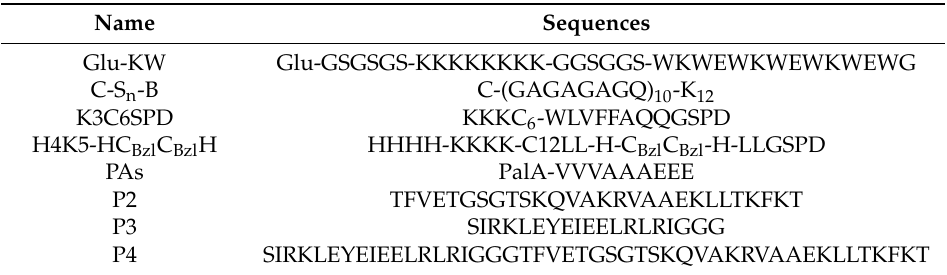
Table 4. Peptide sequence of supramolecular particles for nucleic acid